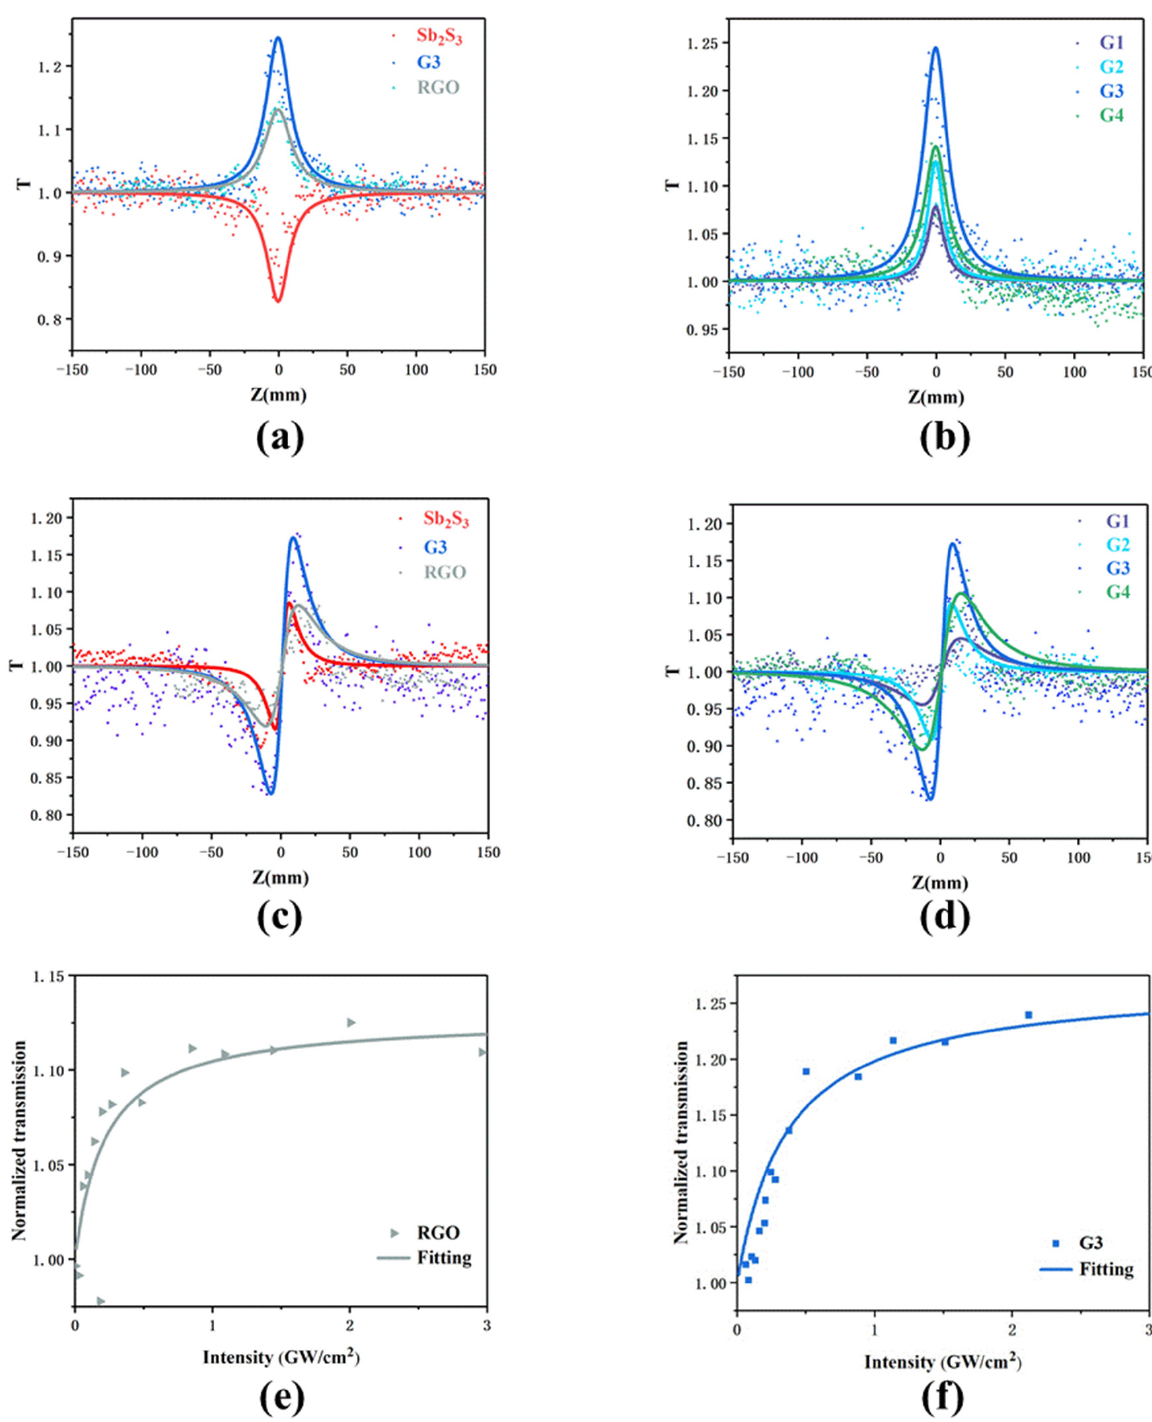
Figure 7. ( a ) Open-aperture Z-scan curves of Sb 2 S 3 , RGO, and the Sb 2 S 3 /RGO composite G3; ( b ) open-aperture Z-scan curves of composites G1–G4. ( c ) Closed-aperture/open-aperture Z-scan curves of Sb 2 S 3 , RGO, and the Sb 2 S 3 /RGO composite G3; ( d ) closed-aperture/open-aperture Z-scan curves of composites G1–G4. ( e , f ) Normalized transmission versus input intensity of RGO and G3. The curves in Figure 7a are the Z-scan curves of Sb 2 S 3 , G3 (Sb 2 S 3 /RGO-0.5), and RGO, reflecting the variation of nonlinear absorption characteristics. The curves of RGO and Sb 2 S 3 /RGO appear as symmetrical peaks at the focus, indicating the dominant position of saturation absorption (SA) in the NLO absorption mechanism; the saturated ab- sorption of G3 shows an increasing trend compared with that of G1–G2. Generally, SA happens in the resonant region where the photon energy is larger than or equal to the band gap of the materials due to the electrons’ excitation from valence band to conduc- tion band and then the Pauli-blocking induced bleaching effect [43]. In the state of suffi-